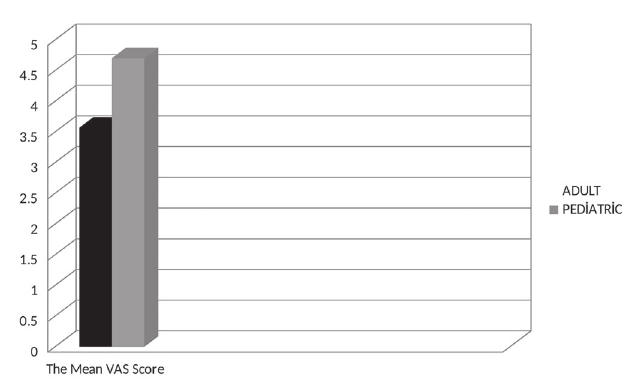
Figure 1 - The chart of the mean VAS scores of the pediatric and adult patient